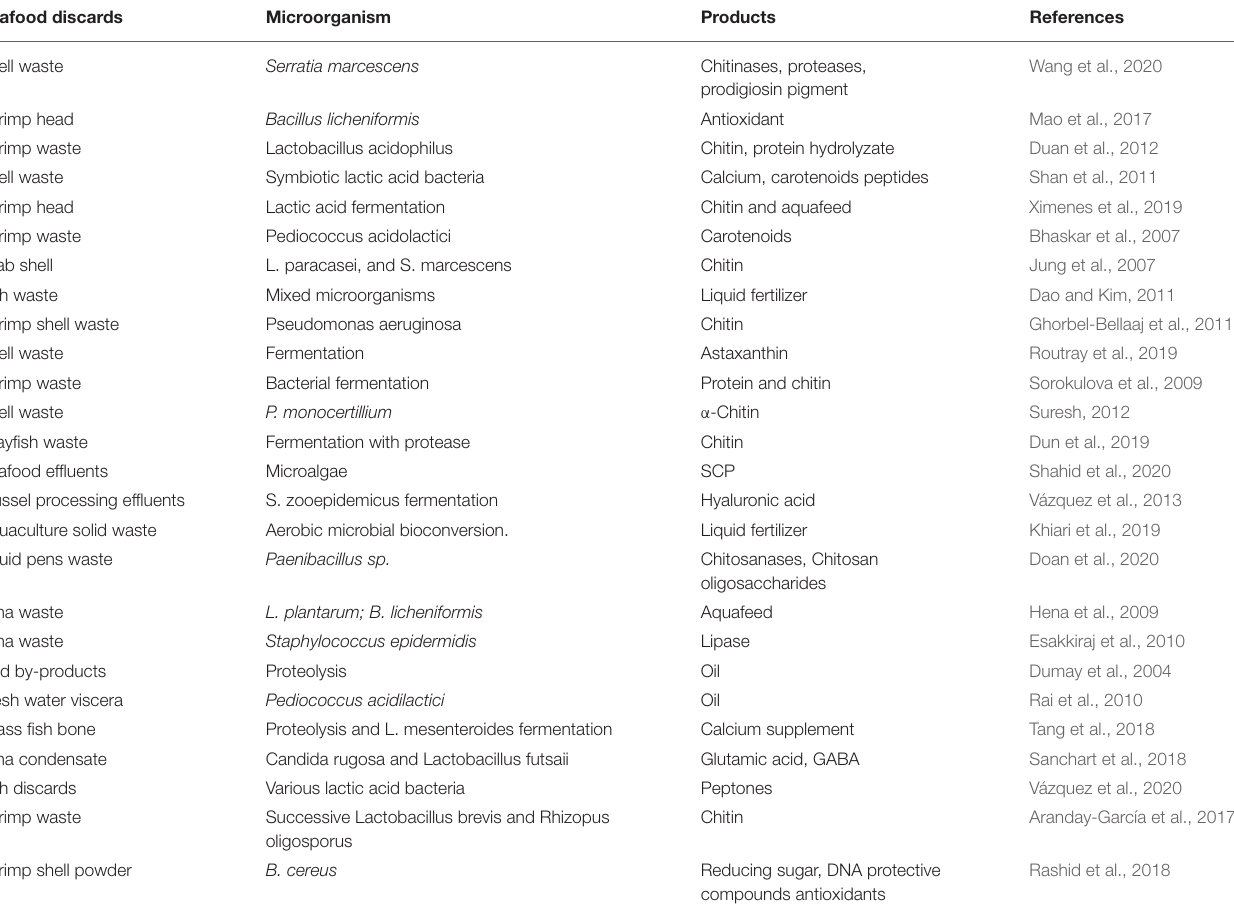
TABLE 4 | Bioconversions of seafood processing discards by